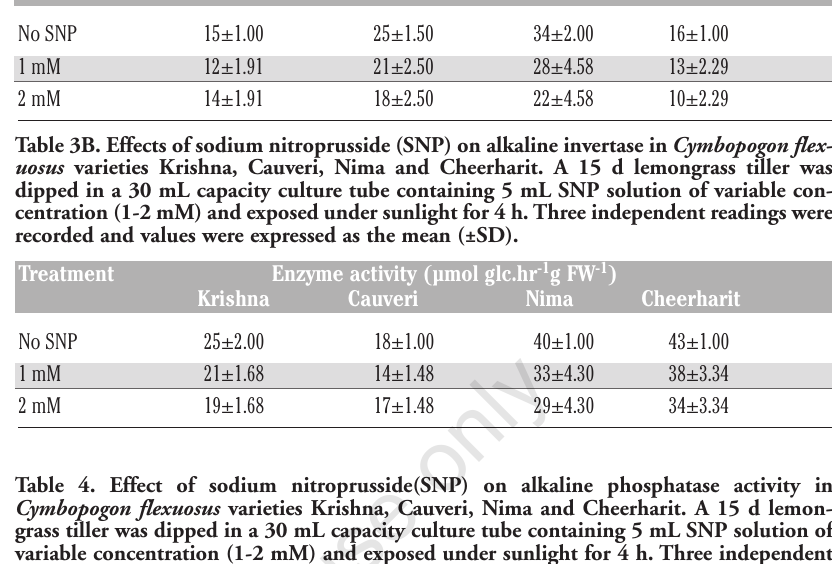
Table 3A. Effect of sodium nitroprusside (SNP) on acid invertase in Cymbopogon flexuo- sus varieties, Krishna, Cauveri, Nima and Cheerharit. A 15 d lemongrass tiller was dipped in a 30 mL capacity culture tube containing 5 mL SNP solution of variable concentration (1-2 mM) and exposed under sunlight for 4 h. Three independent readings were recorded and values were expressed as the mean (± SD).